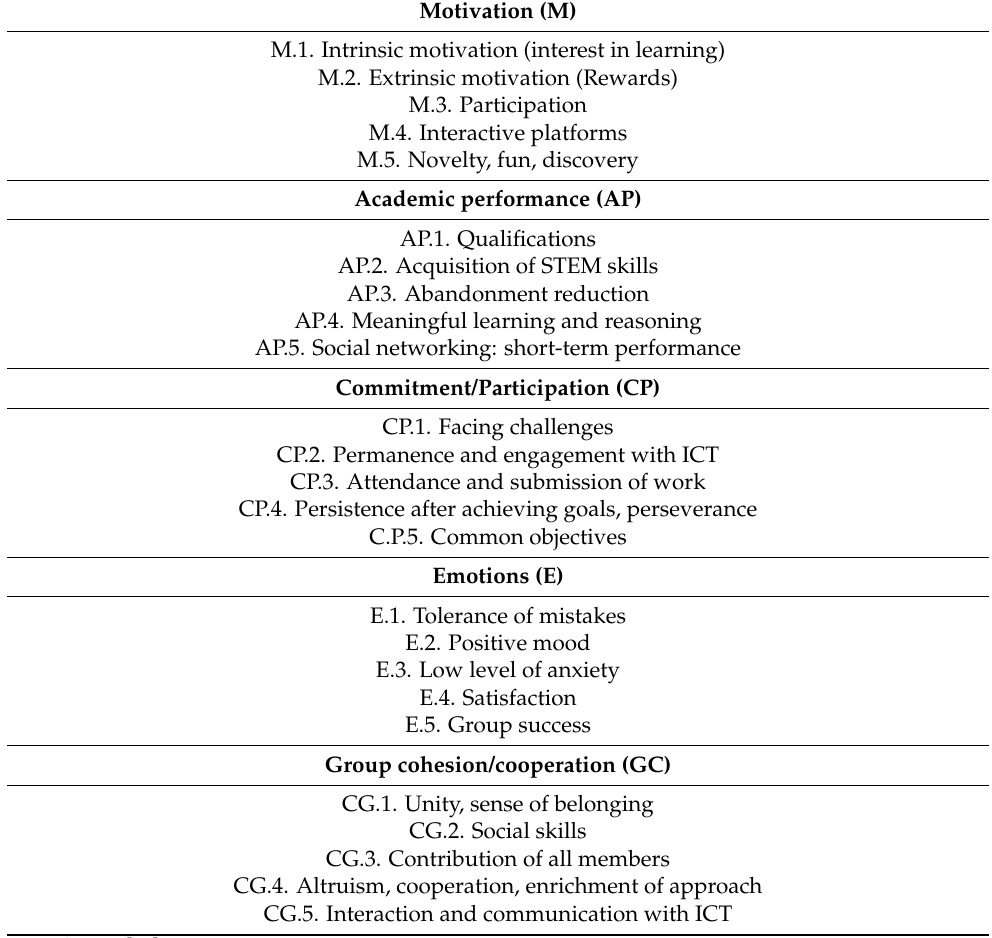
Table 10. Categories and